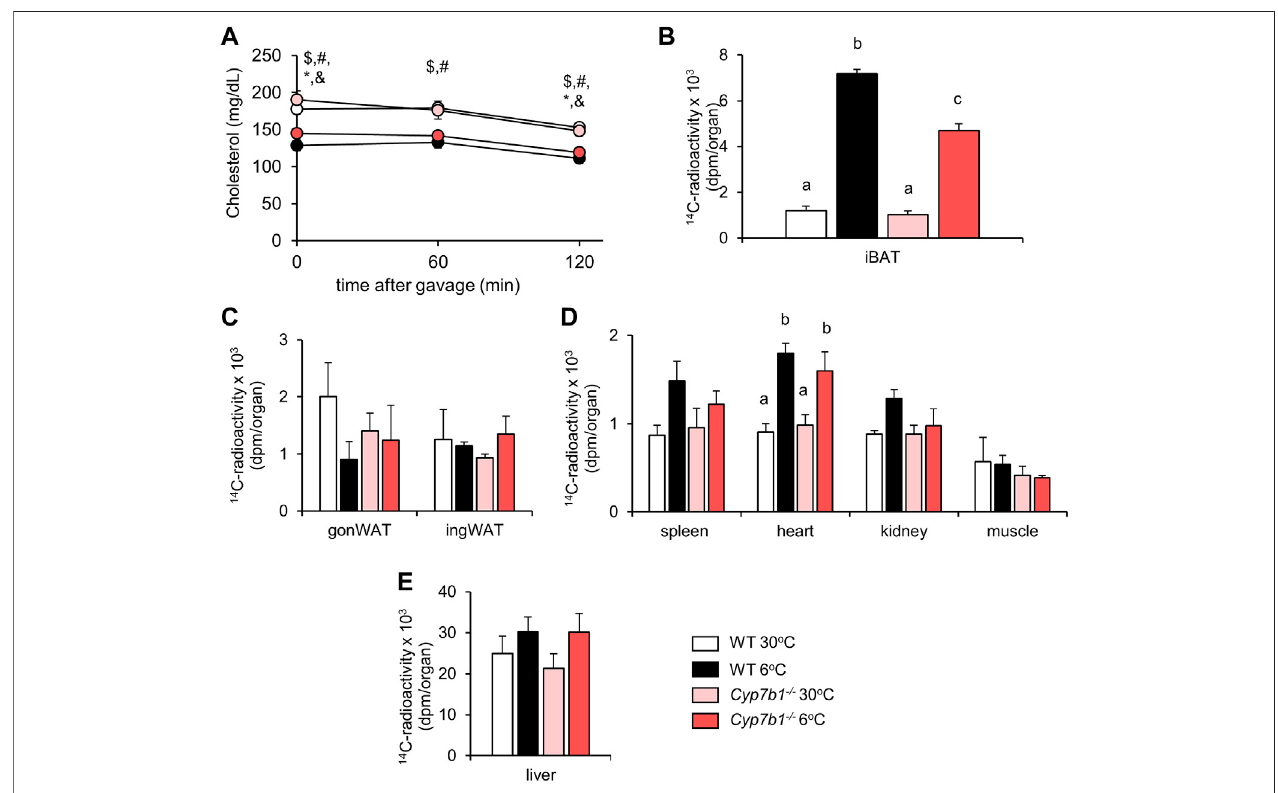
FIGURE3| Cyp7b1 deletioncompromisescold-inducedchylomicronremnantuptakeintoBAT.WTand Cyp7b1 − / − littermatesfedaWTDwerehousedfor1 week either at thermoneutral (30 ° C) or cold (6 ° C) environment before being subjected to a fat tolerance test (OFTT) with 3 H-triolein/ 14 C-cholesterol-traced oral gavage (same experimental setup with Figure 2 ). Plasma cholesterol levels (A) , plasma triglyceride levels, total uptake of 14 C-cholesterol in brown (B) and white (C) adipose tissue depots as well as other metabolic organs (D, E) (n = 5/group). Data are shown as mean values ±SEM. For Panel (A) p values lower than 0.05 were considered statistically signi fi cant and are indicated as follows: $ = WT30 vs. WT 6; * = WT 6 vs. KO 30; # = WT 30 vs. KO 6; & = KO 30 vs. KO 6; For panel (B – E) : Different letters indicate signi fi cant differences between groups ( p < 0.05) determined by two-way ANOVA.